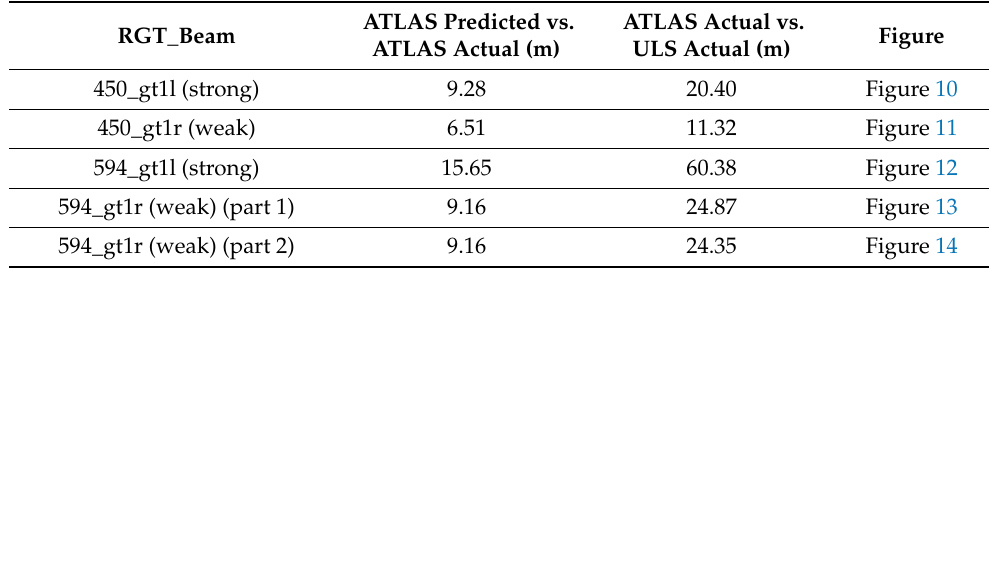
Table 5. Average distances of ATLAS predicted vs. ATLAS actual and ATLAS actual vs. ULS actual. Values calculated for entire glacier crossings . Note that Figures 9–13 highlight 2–3 km sections for each